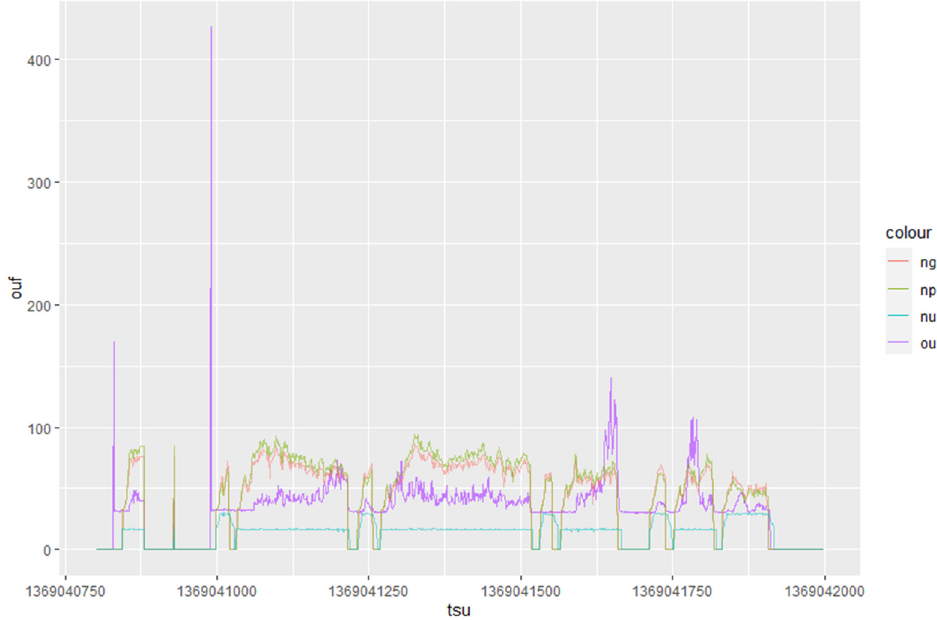
Figure 4. A plot of the variation of recorded current intensities as a function of time. Source: Own study.